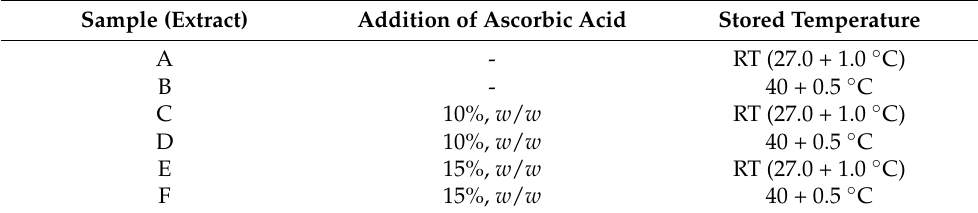
Table 1. Sample preparation of stability